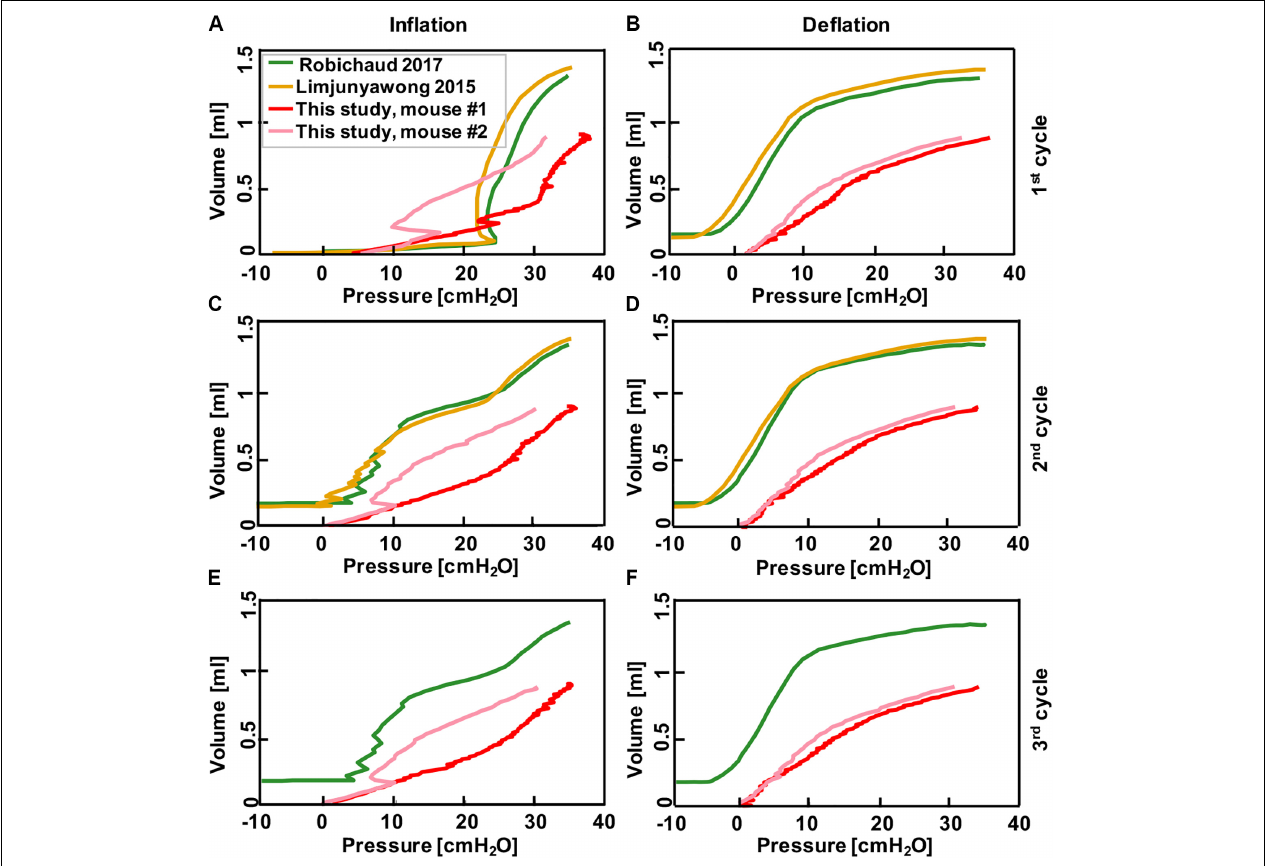
FIGURE 6 | Comparison between results collected from pressure-control systems in the literature where mice lungs were inflated to 35 cmH 2 O after degassing (Limjunyawong et al., 2015b; Robichaud et al., 2017), and the results obtained from this current study where mice lung were inflated to volume of 0.9 ml using the volume-controlled device. Graphs show continuous volume-pressure curves during inflation in first, second, and third cycles (A,C,E) and corresponding deflations (B,D,F) , respectively. Rate of inflation-deflation were 0.083, 0.05, 0.9, and 0.1 ml/s for Robichaud et al. (2017)and Limjunyawong et al. (2015b), mouse #1 and mouse #2, respectively. Despite the significant differences in tissue preparation and loading techniques in these studies, results demonstrate comparable inflation-deflation